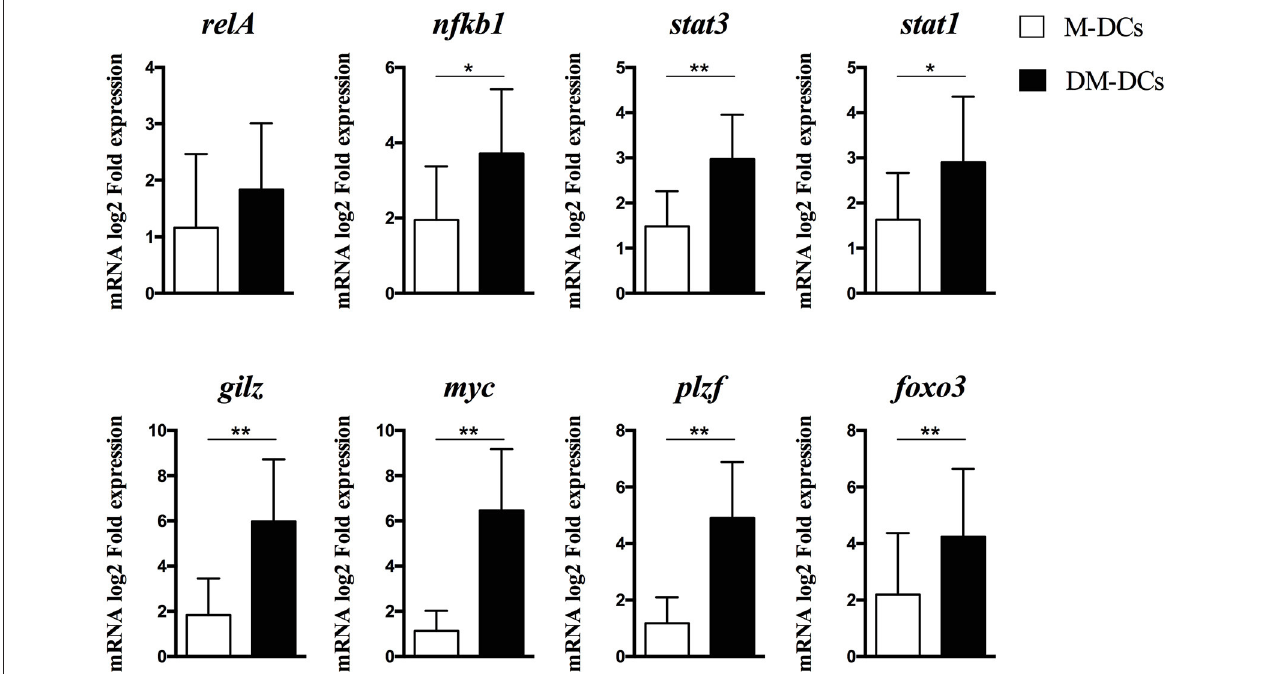
FIGURE 1 | Gene expression levels of main transcription factors described as upstream regulators in Dex-modulated and MPLA-activated dendritic cells (DM-DCs). mRNA levels of transcription factors potentially involved in DM-DCs upstream regulation of gene expression as determined by IPA analysis was assessed by real time PCR. Shown are fold expression values of MPLA-matured DCs (M-DCs) and DM-DCs calculated relative to untreated DCs expression (DCs) ( n = 10; * p = 0.05, ** p = 0.01).